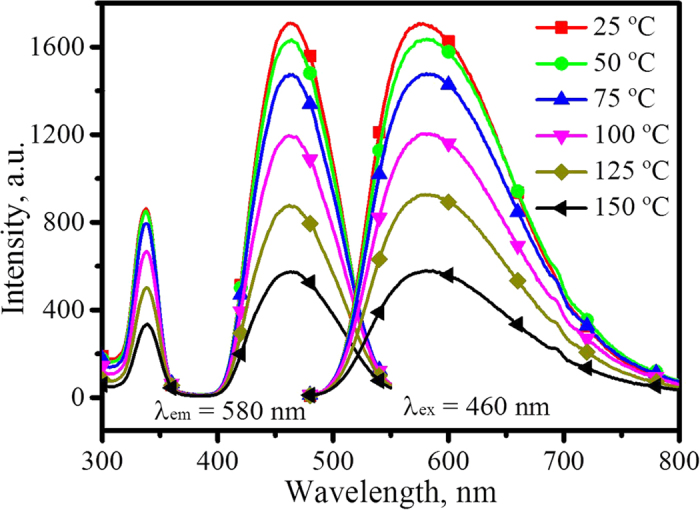
Emission and excitation spectra of (Y0.1Gd0.9)2.94Al5O12: 0.06Ce3+ at various temperatures.